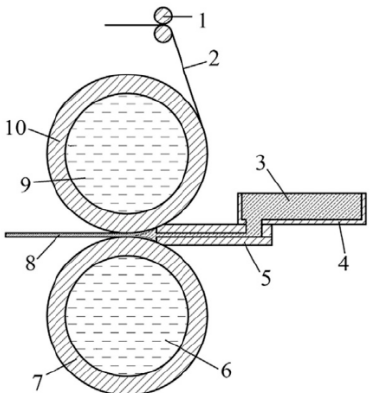
Figure 4. Schematic diagram of roll casting process: 1—Self-made pinch roll; 2—Cu belt; 3—Al melt; 4—Sluice; 5—Nozzle; 6, 9—Cooling water; 7—Lower roll; 8—Clad sheet; 10—Upper roll.